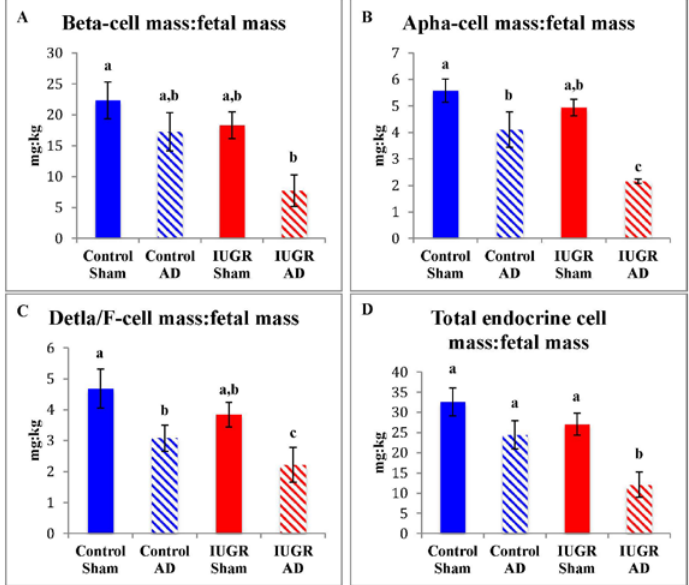
Figure 5. Endocrine cell mass relative to fetal mass. Means are graphed for β -cell ( A ); α-cell ( B ) combined δ-cell and F-cell ( C ); and total endocrine cell ( D ) mass expressed as a proportion of fetal mass (mg/kg). The treatment groups are presented on the x-axis. Error bars represent the SEM and different superscripts denote statistically significant differences among treatment groups ( p <